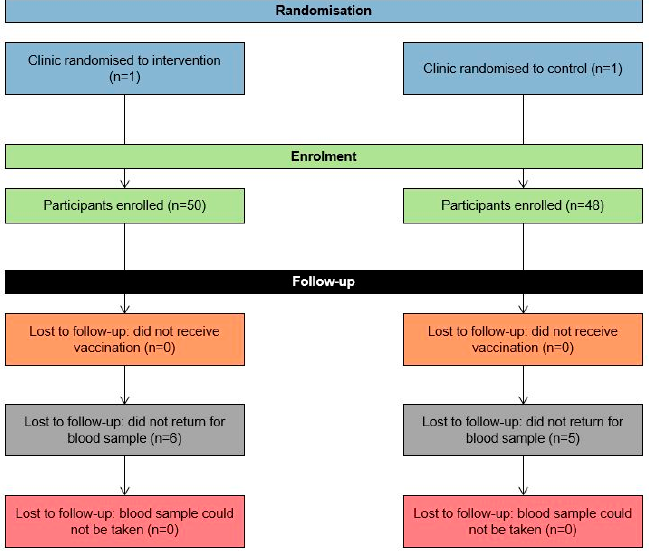
Figure 10. CONSORT flow diagram providing details on the enrolment, allocation and follow-up frequencies for the study.